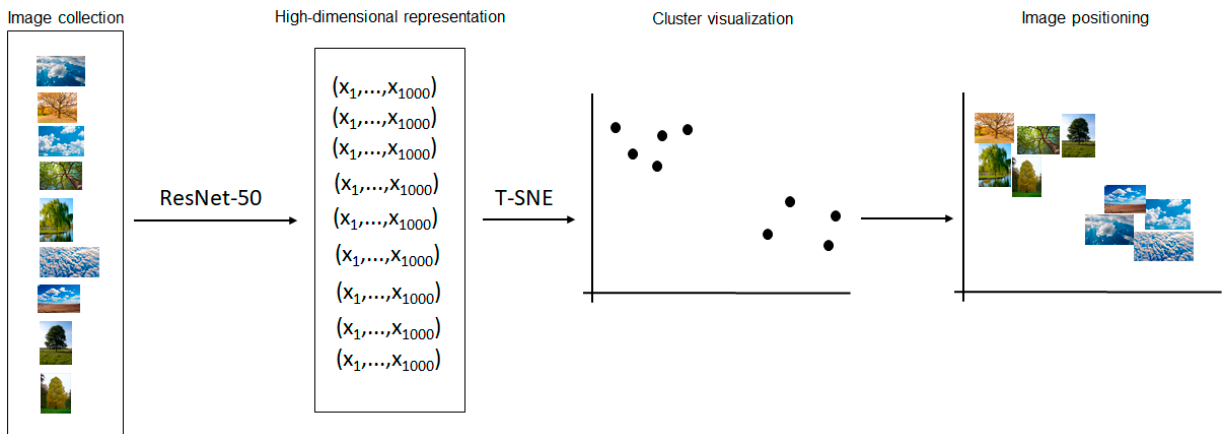
Figure 1. ResNet-50 embeds image collection into high-dimensional space; T-SNE reveals the exist- ence of clusters in this space by mapping the set of points in the plane.